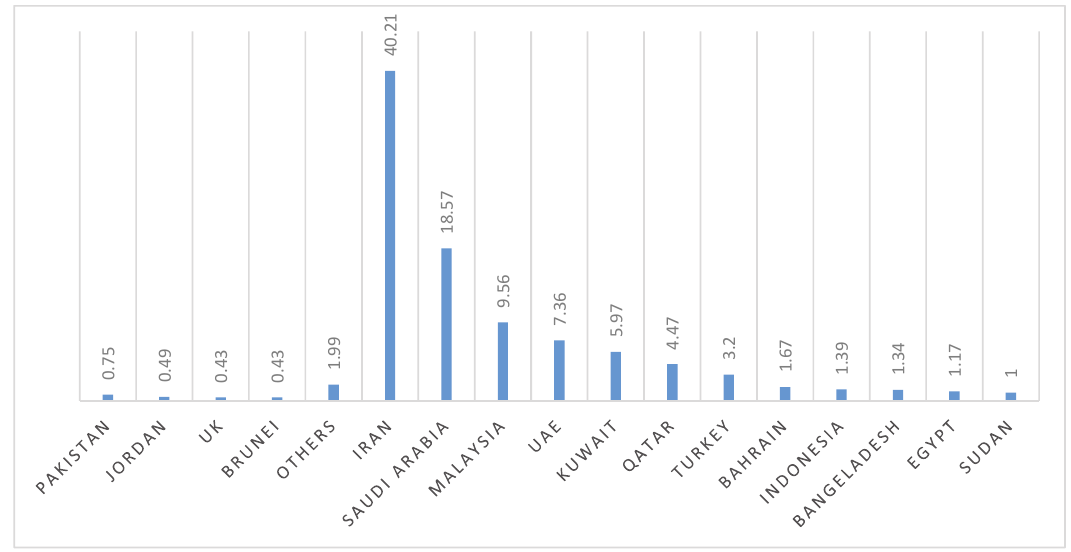
Fig. 2. Source: IFSB Stability Report,